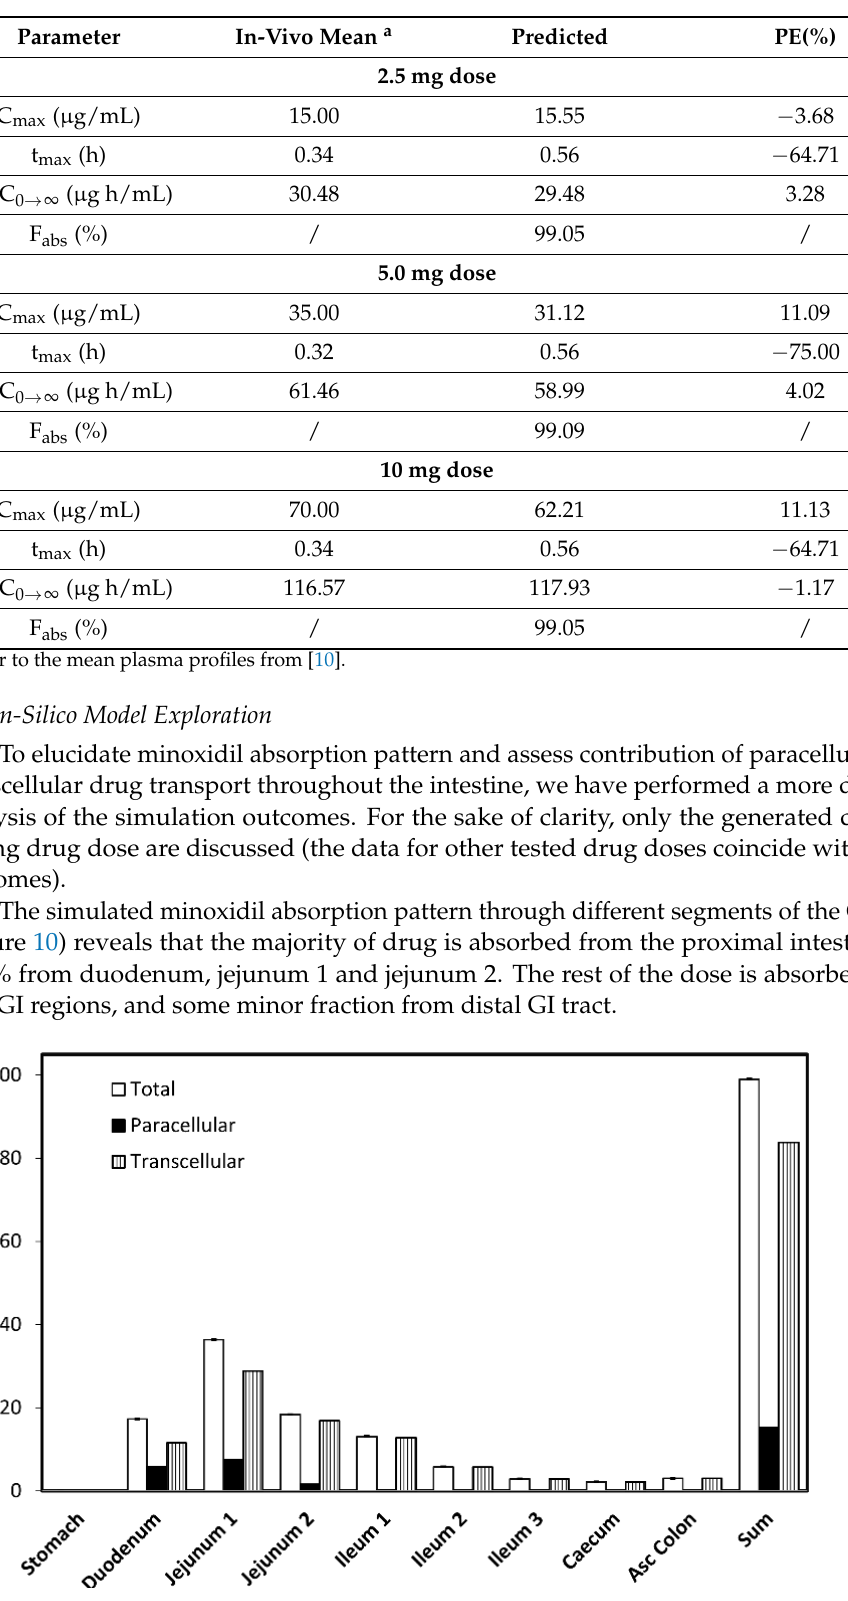
Table 4. Comparison between the simulated and in-vivo observed minoxidil pharmacokinetic parameters following oral administration of different drug doses.